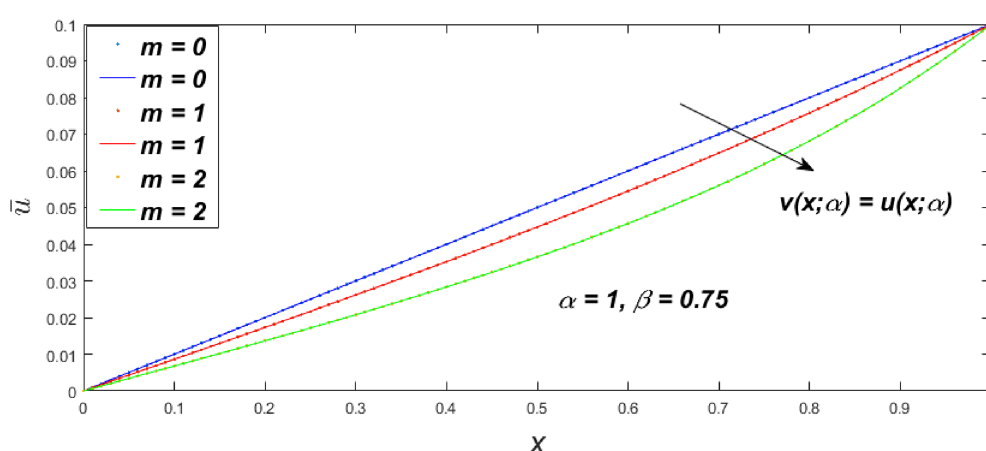
Figure 6. Fuzzy velocity profiles for the impact of